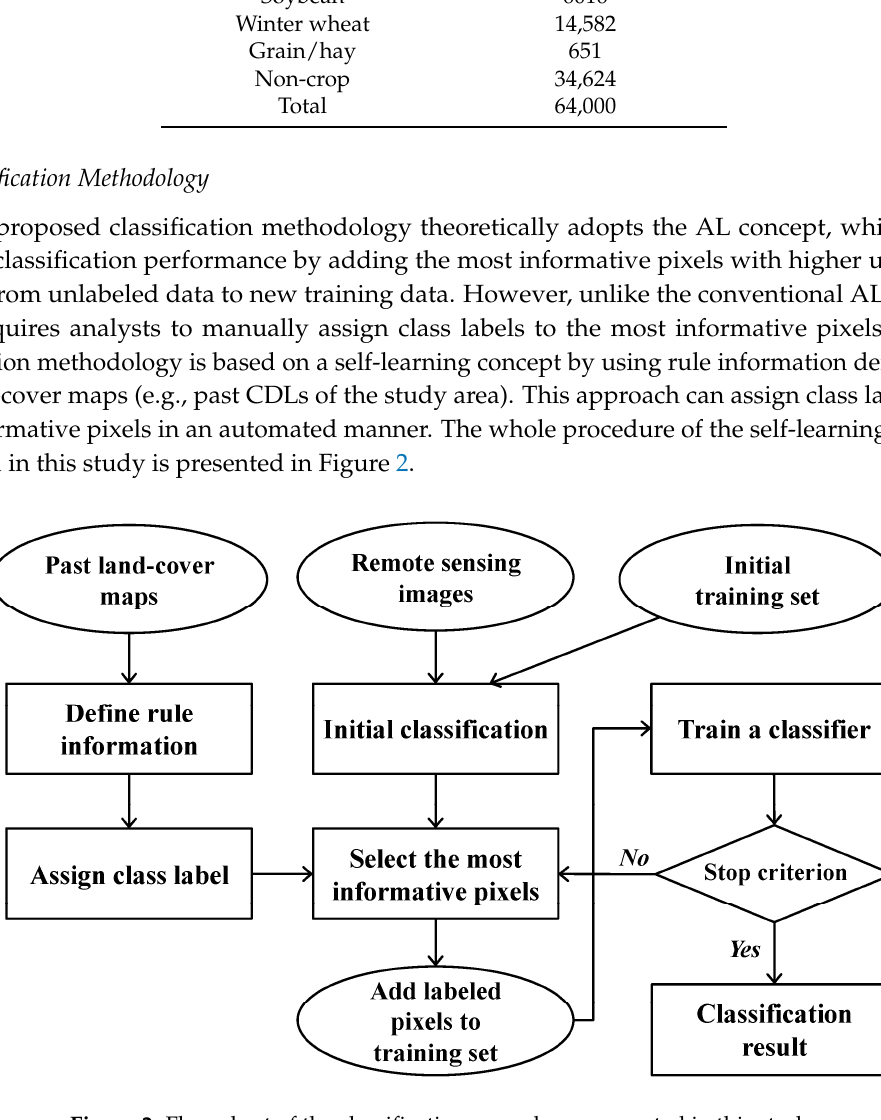
Figure 2. Flow chart of the classification procedures presented in this study.